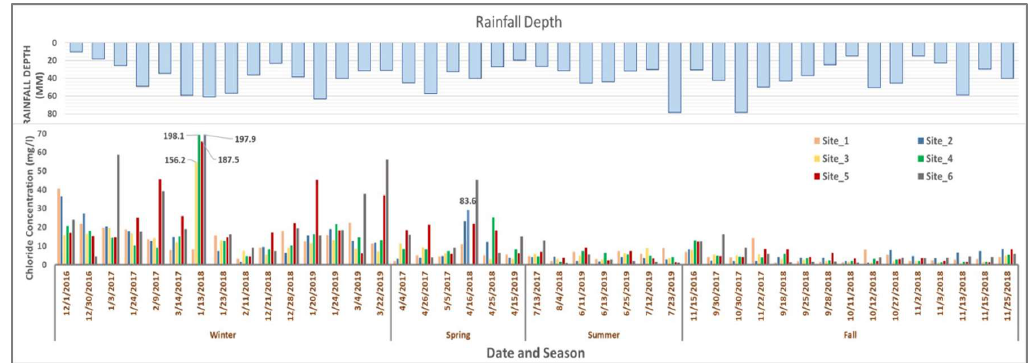
Figure 3. Variability in observed chloride concentrations in runoff are shown, from 2016 to 2019.